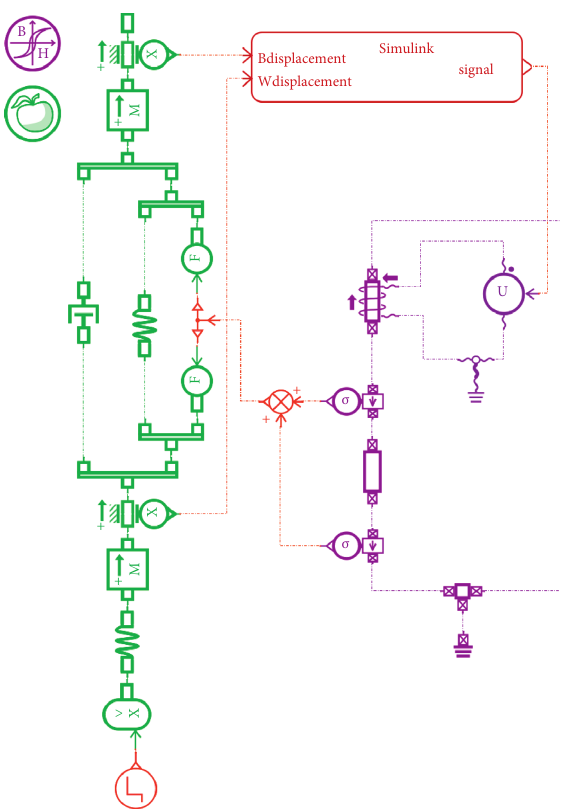
Figure 6: AMESim model of magnetoelectric hybrid semiactive